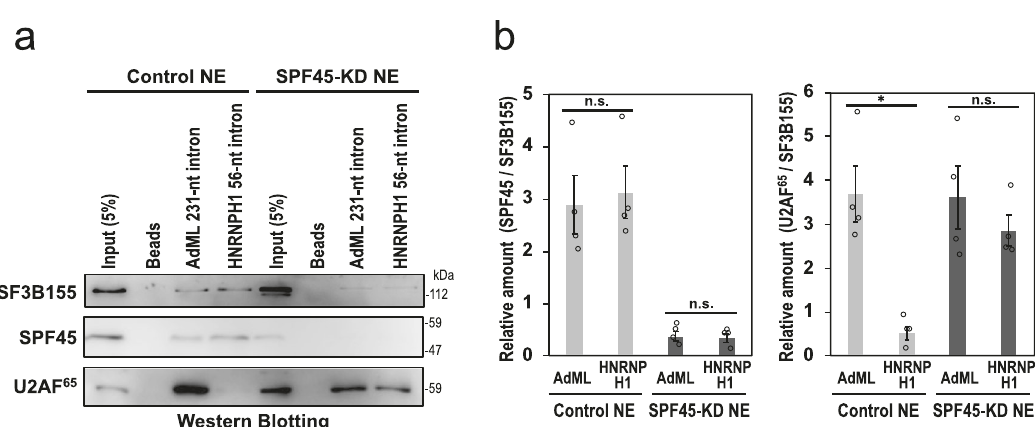
Fig. 5 Binding of SPF45 competes out U2AF 65 on truncated PPTs in short introns. a Af fi nity pull-down experiments of biotinylated RNA indicates U2AF 65 binding to the short intron only if SPF45 was depleted. Biotinylated pre-mRNAs including short HNRNPH1 intron (56 nt) and control AdML intron (231 nt) were incubated with nuclear extracts from either control siRNA- or SPF45 siRNA-treated HEK293 cells. The biotinylated RNA-bound proteins were pulled down with streptavidin-coated beads and analyzed by Western blotting with antibodies against SF3b155, SPF45, and U2AF 65 . b The graph shows quanti fi cation of the bands on Western blots (panel a as the representative blots). SPF45 and U2AF 65 scanned data were normalized to SF3B155 (SPF45/ SF3B155 and U2AF 65 /SF3B155) and plotted. Means ± SEM are given for four independent experiments and two-tailed Student t -test values were calculated (Left panel: p = 0.2982 for AdML vs HNRNPH1 intron in Control NE; p = 0.6973 for AdML vs HNRNPH1 intron in SPF45-KD NE; Right panel: p = 0.0142 for AdML vs HNRNPH1 intron in Control NE, p = 0.4647 for AdML vs HNRNPH1 intron in SPF45-KD NE). * P < 0.05, n.s. P > 0.05. Source data of all the above panels are provided as a Source Data fi